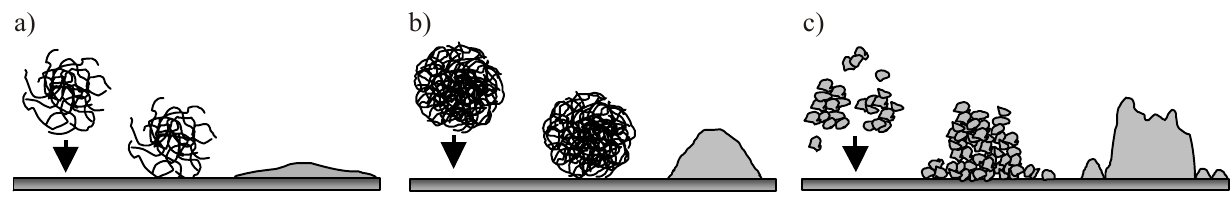
Figure 6. Schematic illustration of PECs adsorbing on the mica surface (left part of the sketch) and the situation after drying (right part) for ( a ) Eth/Eth PEC, ( b ) Isob/Isob PEC and ( c ) Styr/Styr